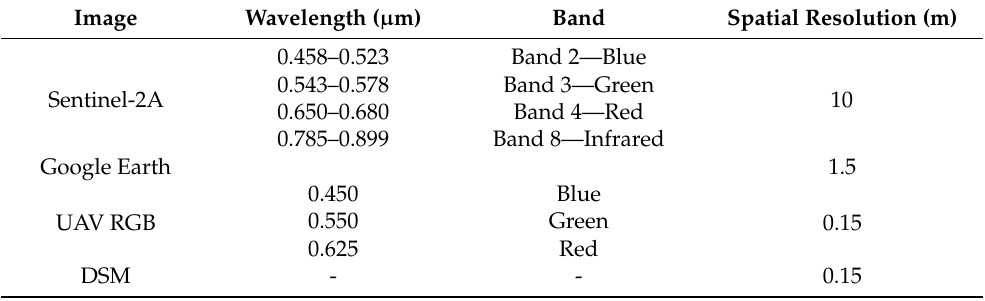
Table 1. Specifications of the Sentinel-2, Google Earth and unmanned aerial vehicle (UAV) images used in this